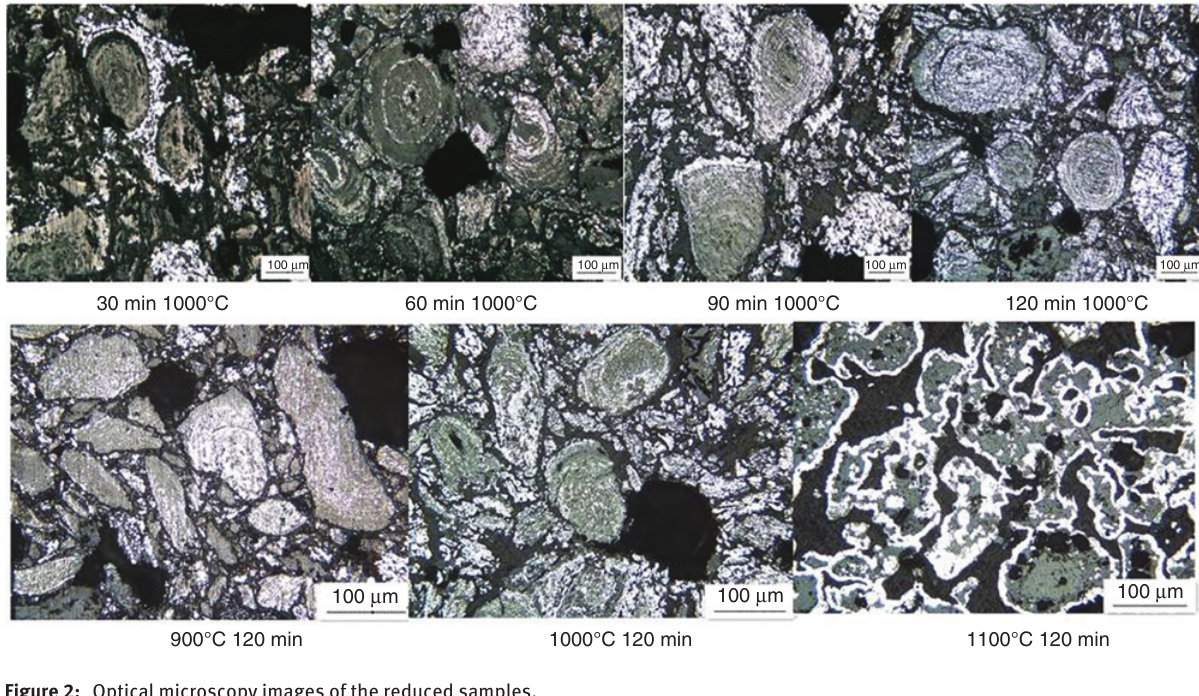
Figure 2: Optical microscopy images of the reduced samples.